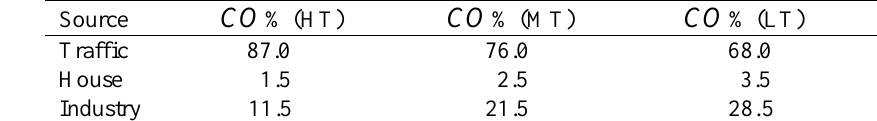
Table 8. C O percent share for sub-groups in the GTA, 2008 Source Traffic